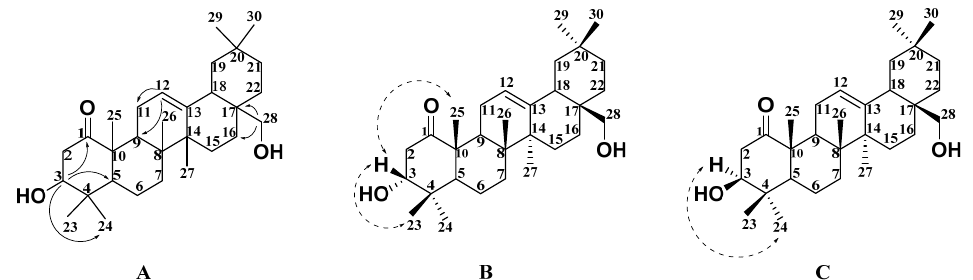
Figure 2. Key HMBC (plain arrow; ( A )), NOESY (dash arrow) correlations of compound 1 ( B ), and NOESY (dash arrow) correlations of compound 4 ( C ) .